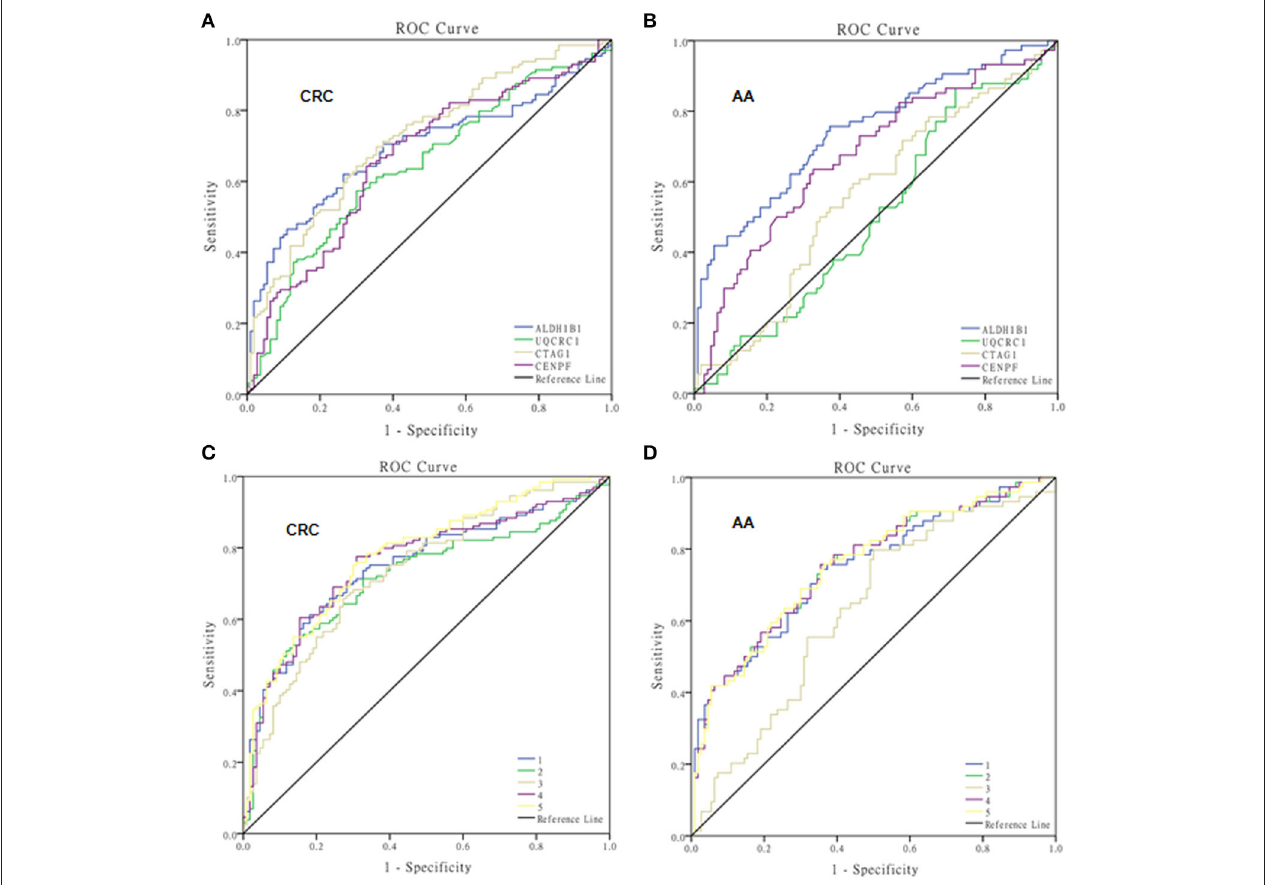
FIGURE 3 | ROC curves of autoantibodies against selected TAAs examined by ELISAs. ROC curves of single TAAs of ALDH1B1, UQCRC1, CTAG1, and CENPF for colorectal cancer (A) and advanced adenoma (B) , and multiple panels of TAAs for colorectal cancer (C) and advanced adenoma (D) . 1, ALDH1B1 + CTAG1; 2,